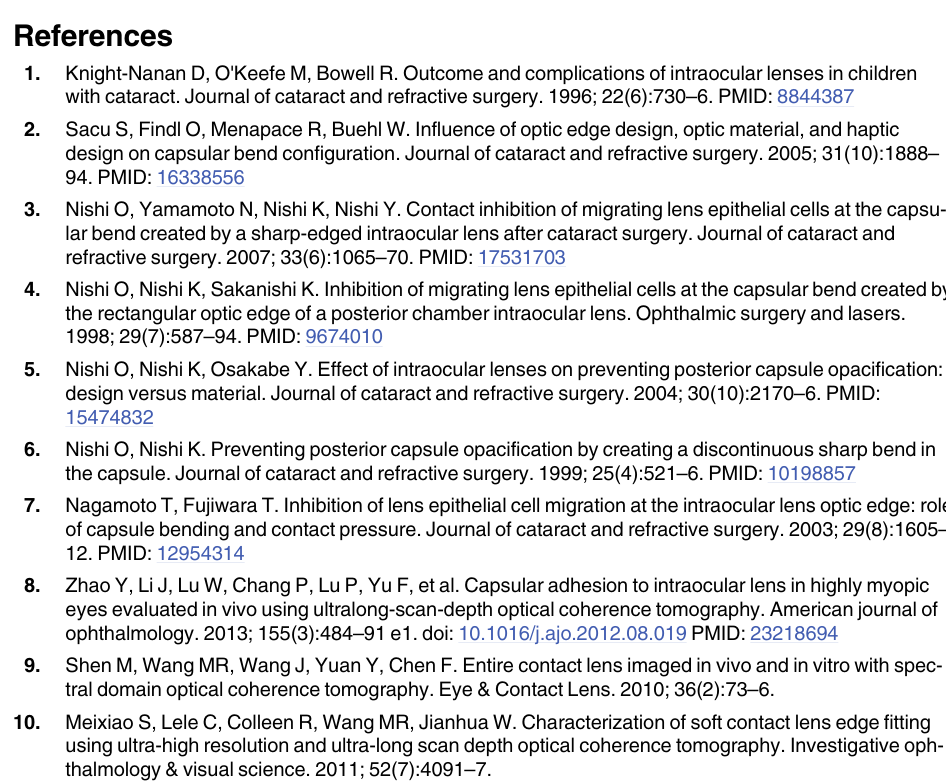
S1 Table. Different capsular bend types and PCO of the whole rabbits at two sides (nasal and temporal)